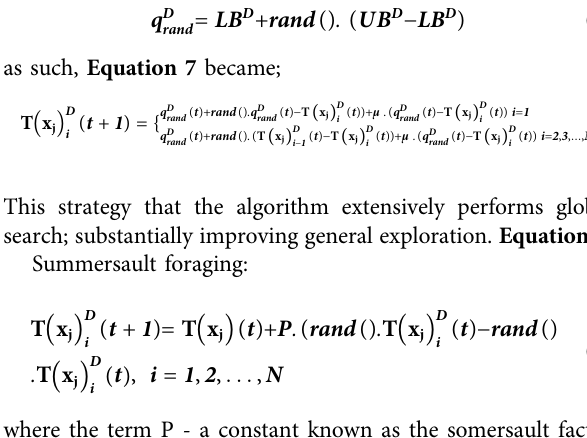
Frontiers in Earth Science |